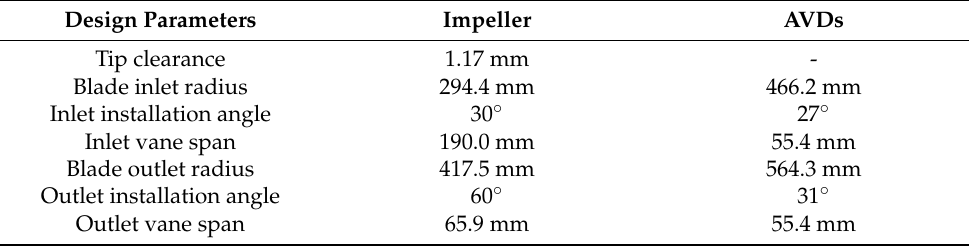
Figure 1. Site map and geometric structure of the research object: ( a ) the experimental compressor and main components; ( b ) the geometry of stage and IBC. Table 1. Main parameters of impeller and